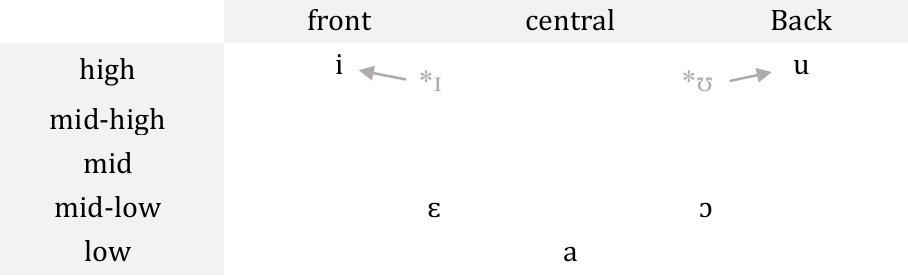
Table 3 : Typical Bantu 5-vowel